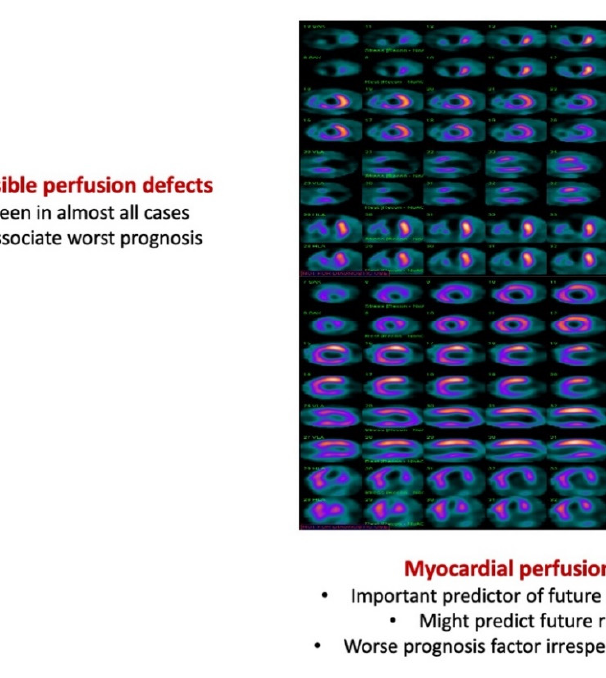
Figure 2. Most important findings by nuclear imaging in patients with systemic sclerosis and primary myocardial disease. Images from the personal collection of the authors.